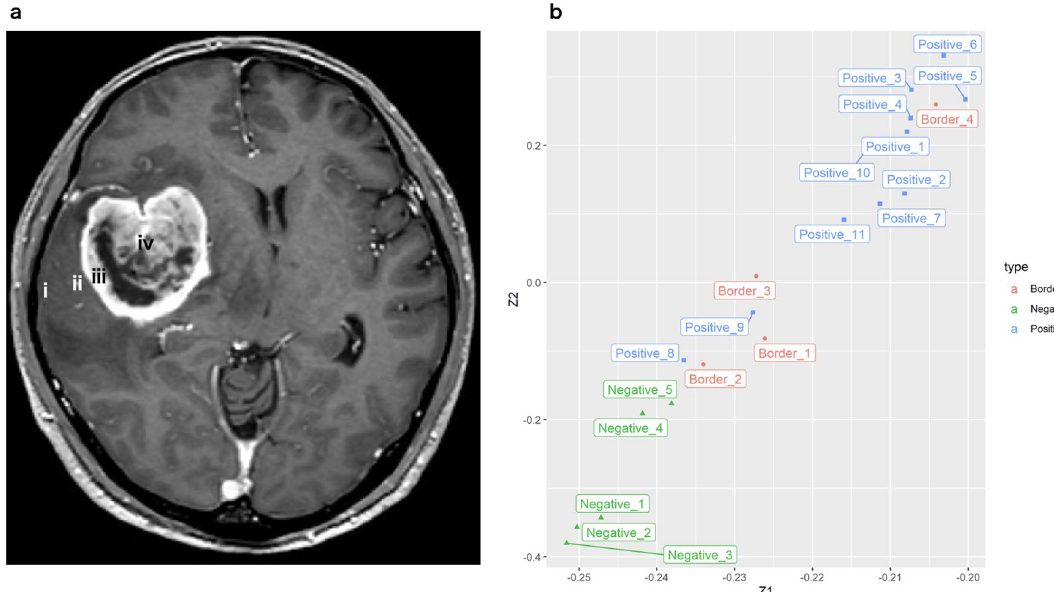
Figure 1. ( a ) Magnetic resonance imaging shows tissue sample collection sites: (i) far from the tumor; (ii) just outside the tumor; (iii) at the tumor periphery; and (iv) at the tumor core. ( b ) The scatterplot of the first and second principal component loadings for GBM and near-normal brain tissues. The x- and y-axis (Z1 and Z2) represent the loadings of the first and second principal components (PC1 and PC2), and colors indicate Positive (blue), Border (red), or Negative (green), respectively. The sum of variance ratios for PC1 and PC2 are 0.90 and 0.94,